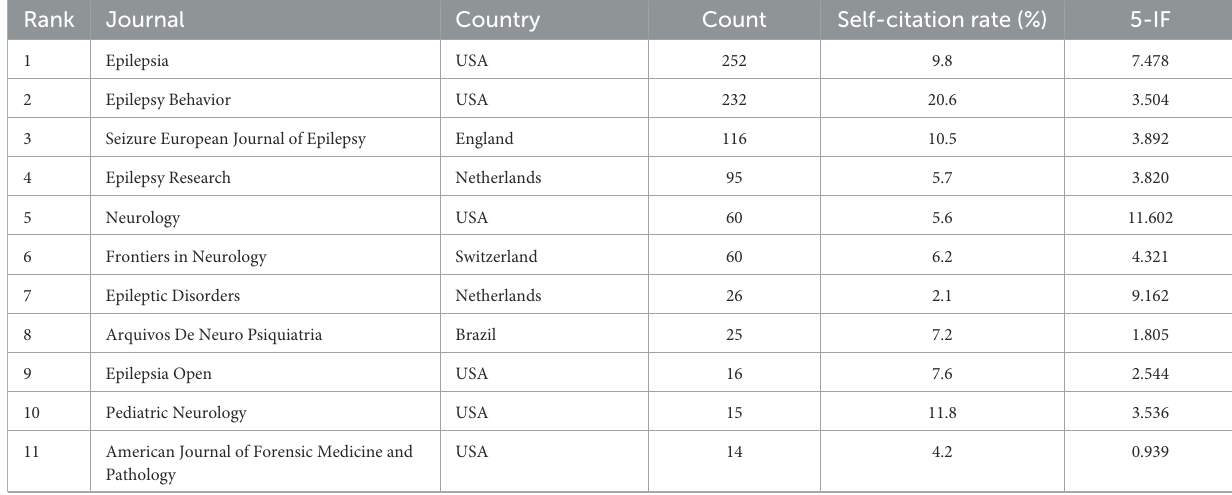
TABLE 4 Core journals which published the highest number of SUDEP